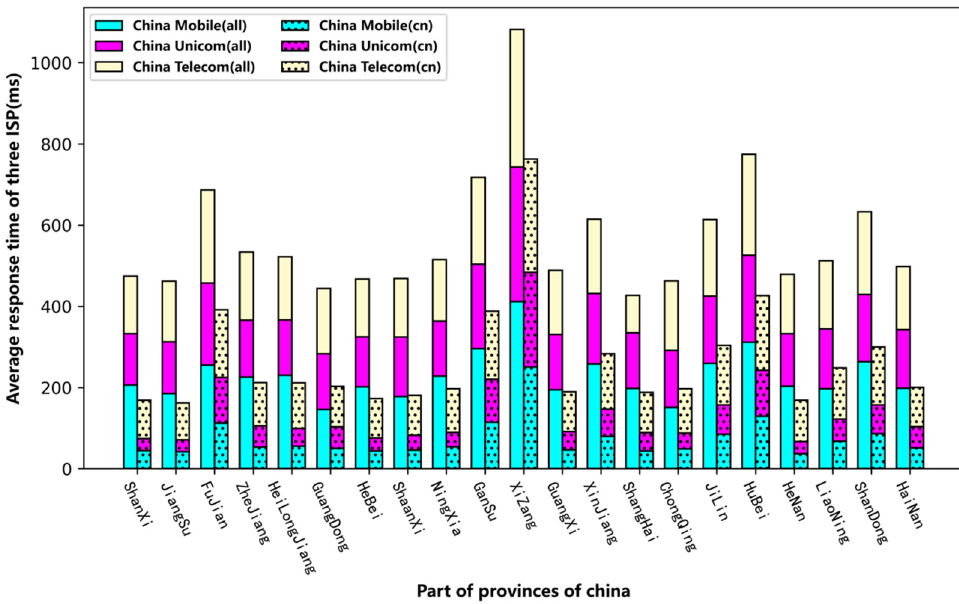
Figure 7. Average response times of accessing roots of three ISPs in different provinces .